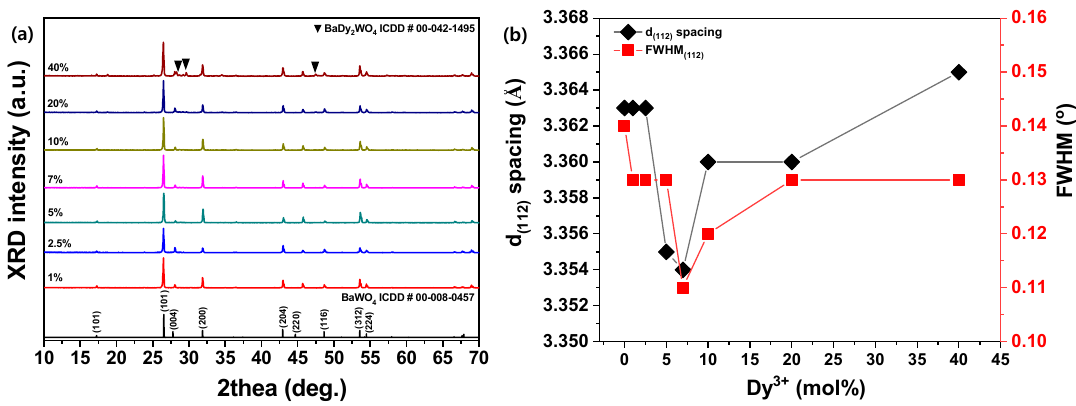
Figure 3. ( a ) XRD patterns and ( b ) lattice constant d (112) spacing and full width at half maximum (FWHM) of Dy 3 + -doped BaWO 4 samples with various rare-earth ions.